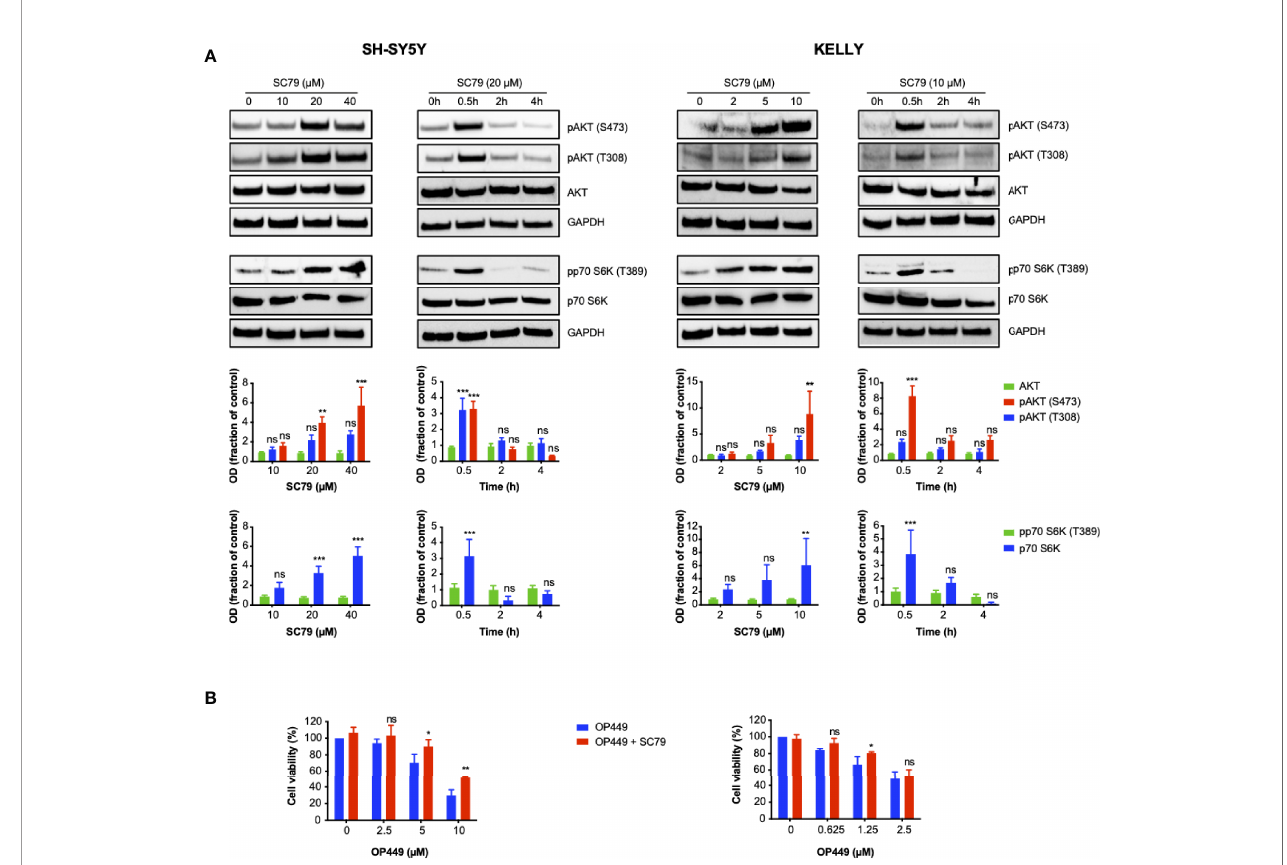
FIGURE 8 | OP449-induced decrease of viability of neuroblastoma (NB) cells is partially rescued by activating AKT. (A) AKT is activated by SC79 depending on dose and time. Cells were treated with increasing doses of SC79 for 0.5 h or with fi xed doses of 10 (KELLY cells) and 20 µM (SH-SY5Y cells) for increasing time. Cell lysates were subjected to Western blotting. GAPDH was used as loading control. The top panels show representative Western blotting; full-length blotting is depicted in Supplementary Figures 9, 10 . The bottom panels show means ± SEM of optical density (OD) measurements of Western blotting of 3 independent experiments. Results are expressed as fraction of OD of untreated control cells. Statistical analysis is performed by two-way ANOVA test. **p < 0.01, ***p < 0.001; ns, not signi fi cant. (B) Viability is partially rescued by AKT activation. Cells were pretreated for 0.5 h with SC79 at 10 µM for KELLY cells and 20 µM for SH-SY5Y cells. SC79 was continued for additional 2 h in the presence of increasing doses of OP449. Results are expressed as percentage of viability of untreated control cells. Statistical analysis is performed by two-way ANOVA test. * p < 0.05, **p < 0.01, ns; not signi fi